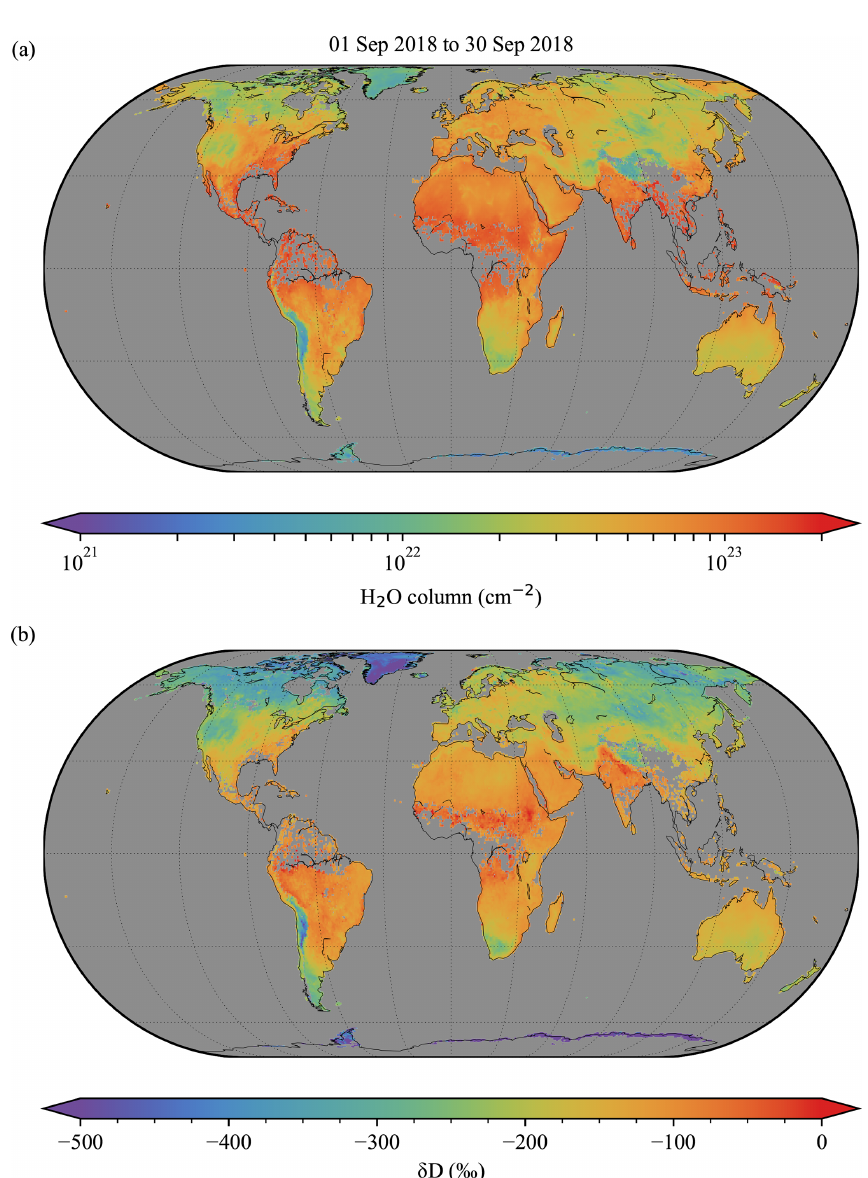
Figure 10. Global plots of H 2 O (a) and δ D (b) averaged over September 2018 on a 0 . 5 ◦ × 0 . 5 ◦ grid. The average of δ D is weighted with the H 2 O column for mass conservation